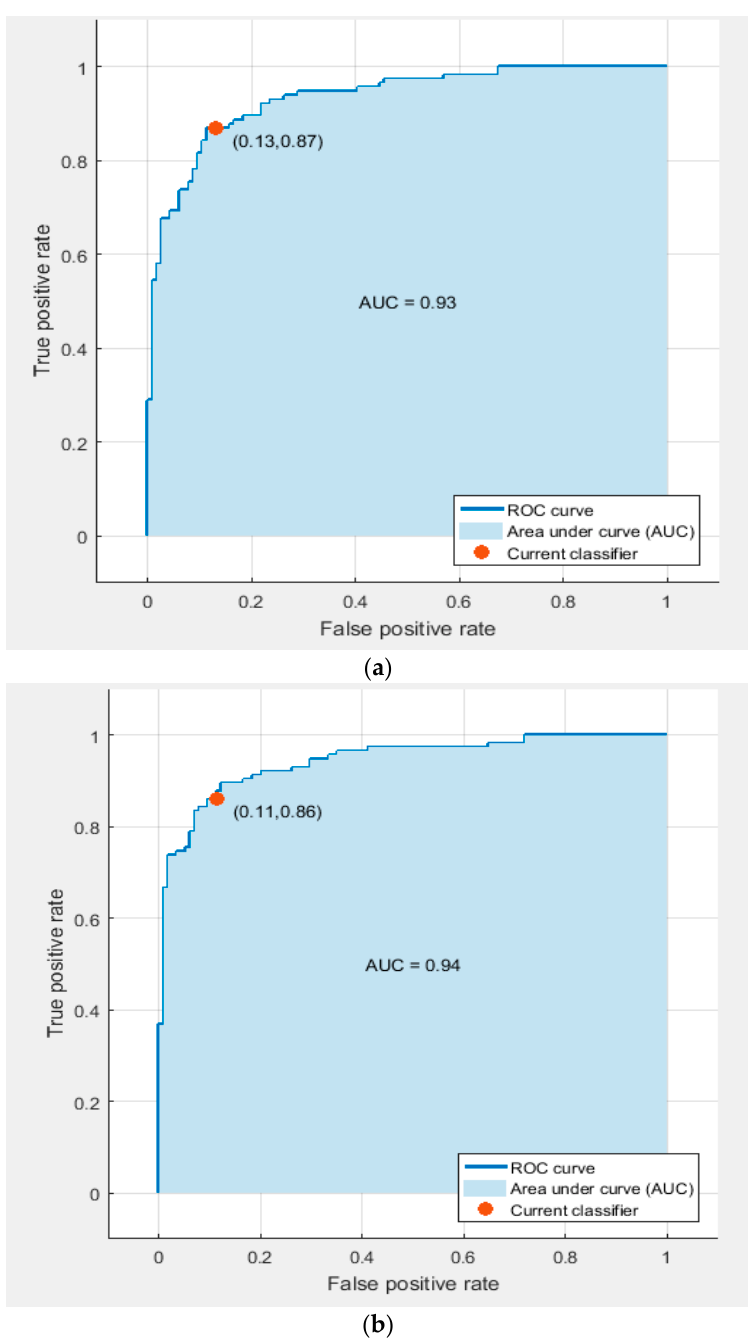
Figure 10. ROC curves and areas under the curve (AUCs) for AlexNet and ResNet 50 fused faetures used to train ( a ) the linear SVM classifier, and ( b ) the quadratic SVM classifier.